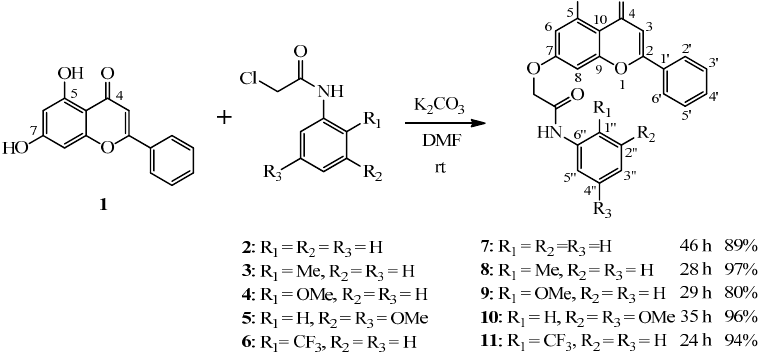
Figure 1. The 15-carbon skeleton of flavonoids.